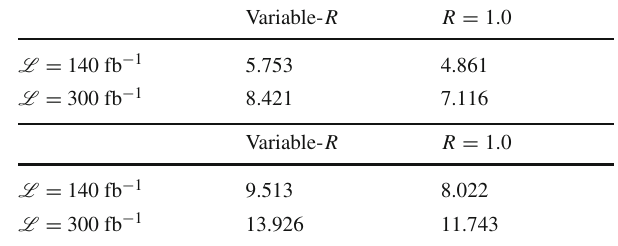
Table 3 Event rates of signal and backgrounds for L = 300 fb − 1 upon enforcing the initial cuts plus the mass selection criteria of Fig. 8 for the two jet reconstruction procedures Process